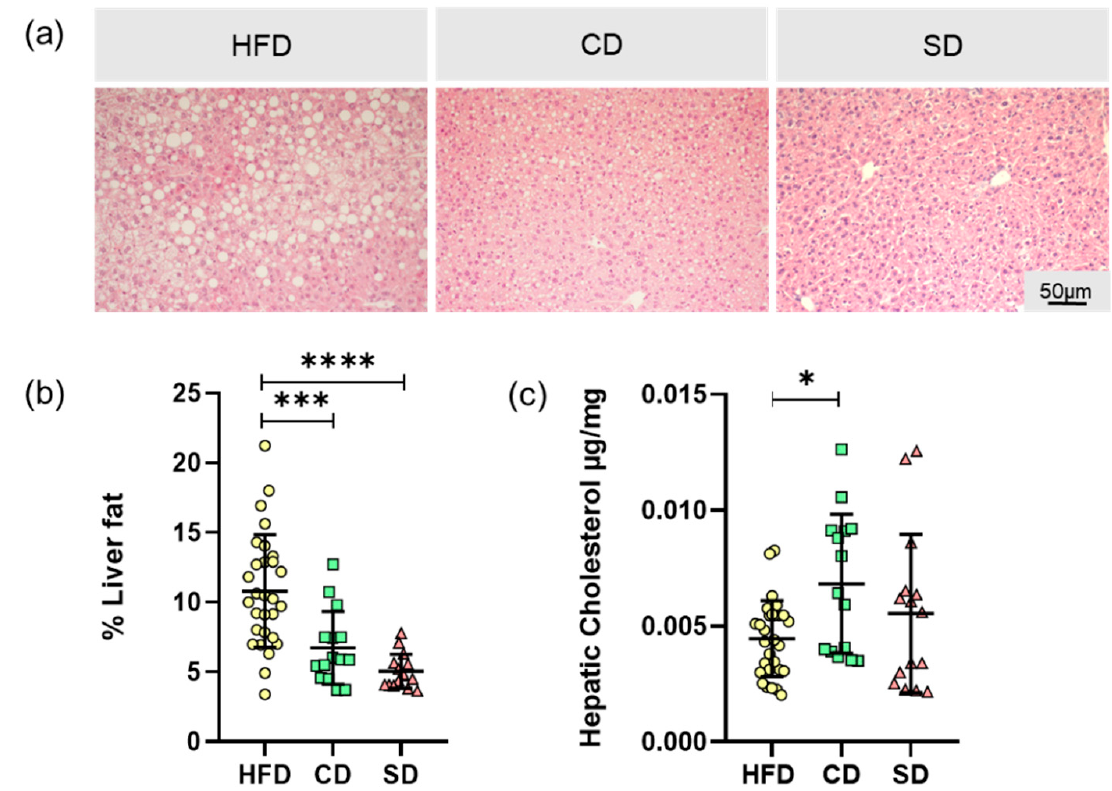
Figure 4. ( a ) Representative LPFs of the livers from mice fed high fat diet (HFD), control diet (CD) or standard diet (SD) (200 × magnification, scale bar representing 50 µ m valid for all three images); ( b ) Percentage of hepatic vesicular fat content; ( c ) Hepatic cholesterol concentration of the HFD, CD and SD group. Data (HFD: n = 29; CD: n = 15, SD: n = 15) presented as mean ± standard deviation. Significance of differences between the groups was tested by Brown–Forsythe and Welch ANOVA in ( b ) or one-way ANOVA on Ranks (Kruskal–Wallis) in ( c ); **** p < 0.0001, *** p < 0.001, * p < 0.05.